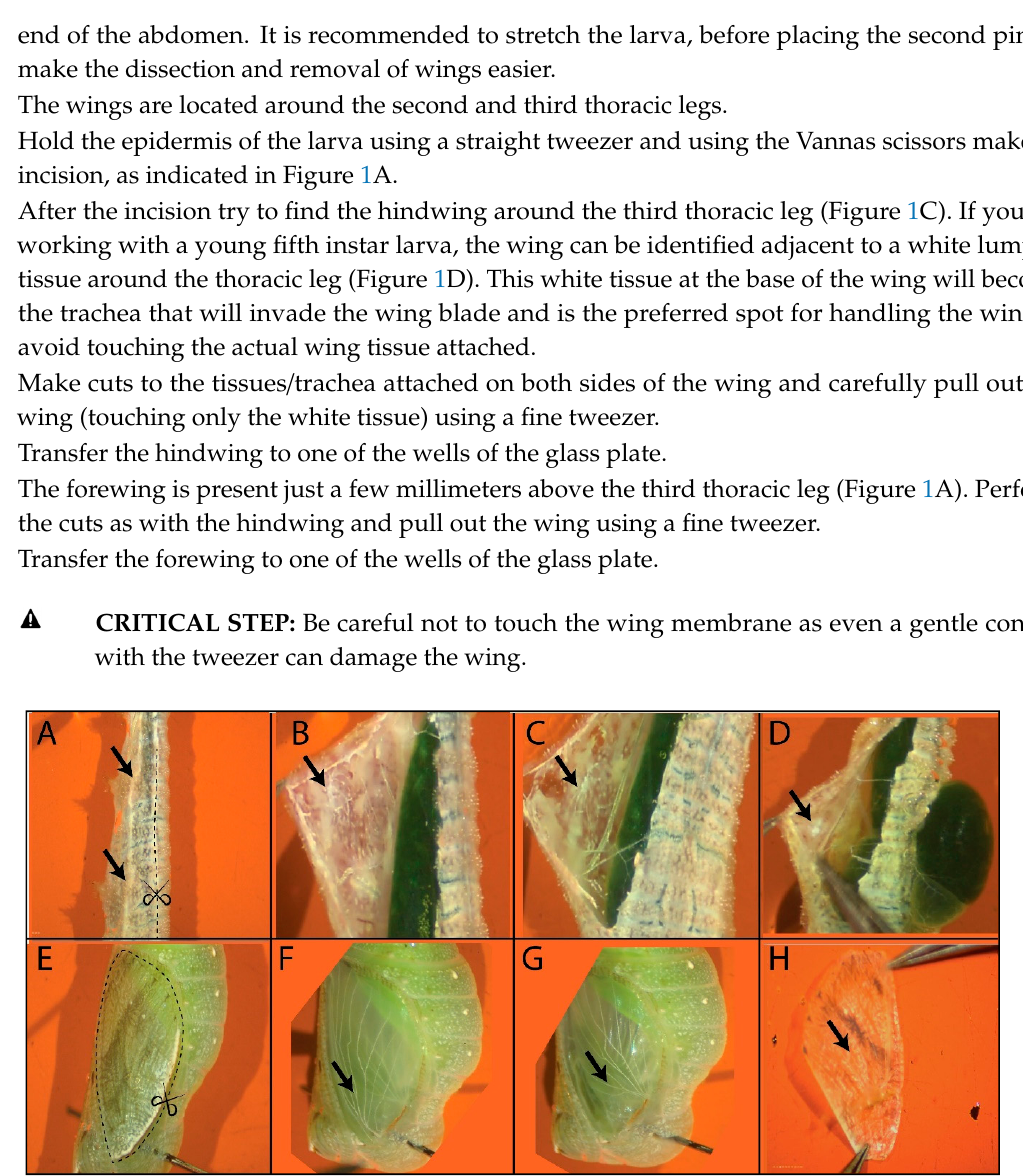
laterally (black arrows), dorsal to the second and third thoracic legs. The region for incision is marked by a dotted line. ( B ). A larval forewing is located dorsally to the second thoracic leg. ( C ). A